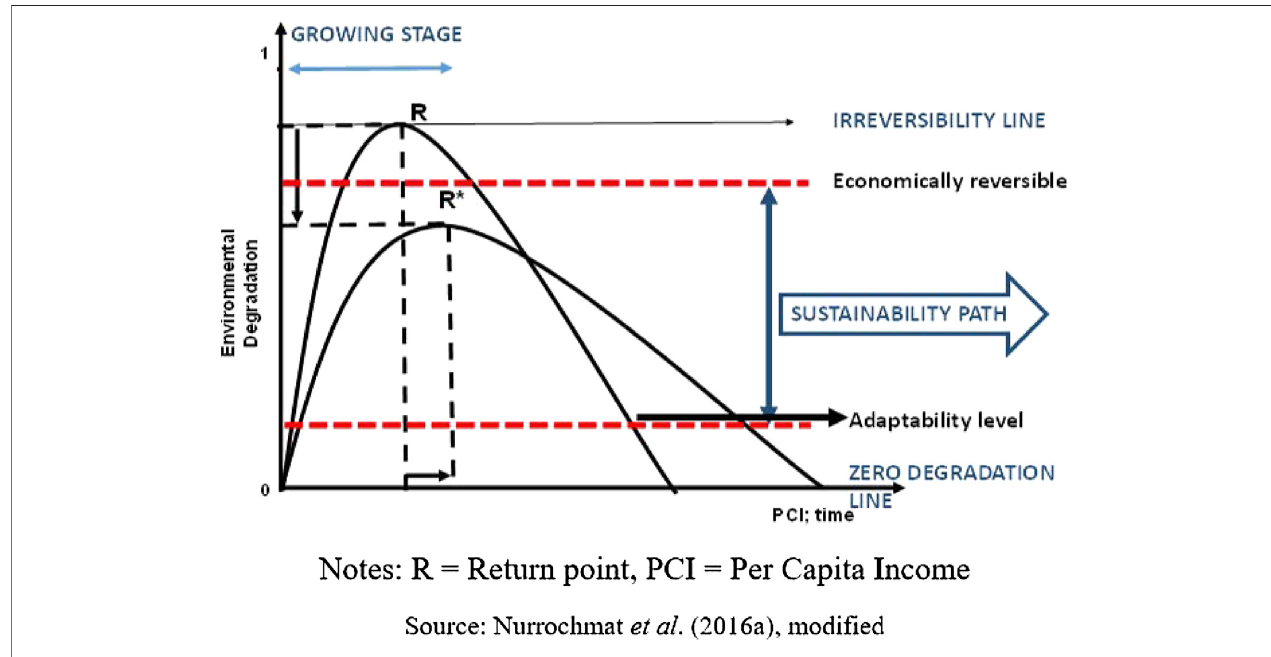
FIGURE 2 | The Concept of reversibility and adaptability in environmental management policy strategies.